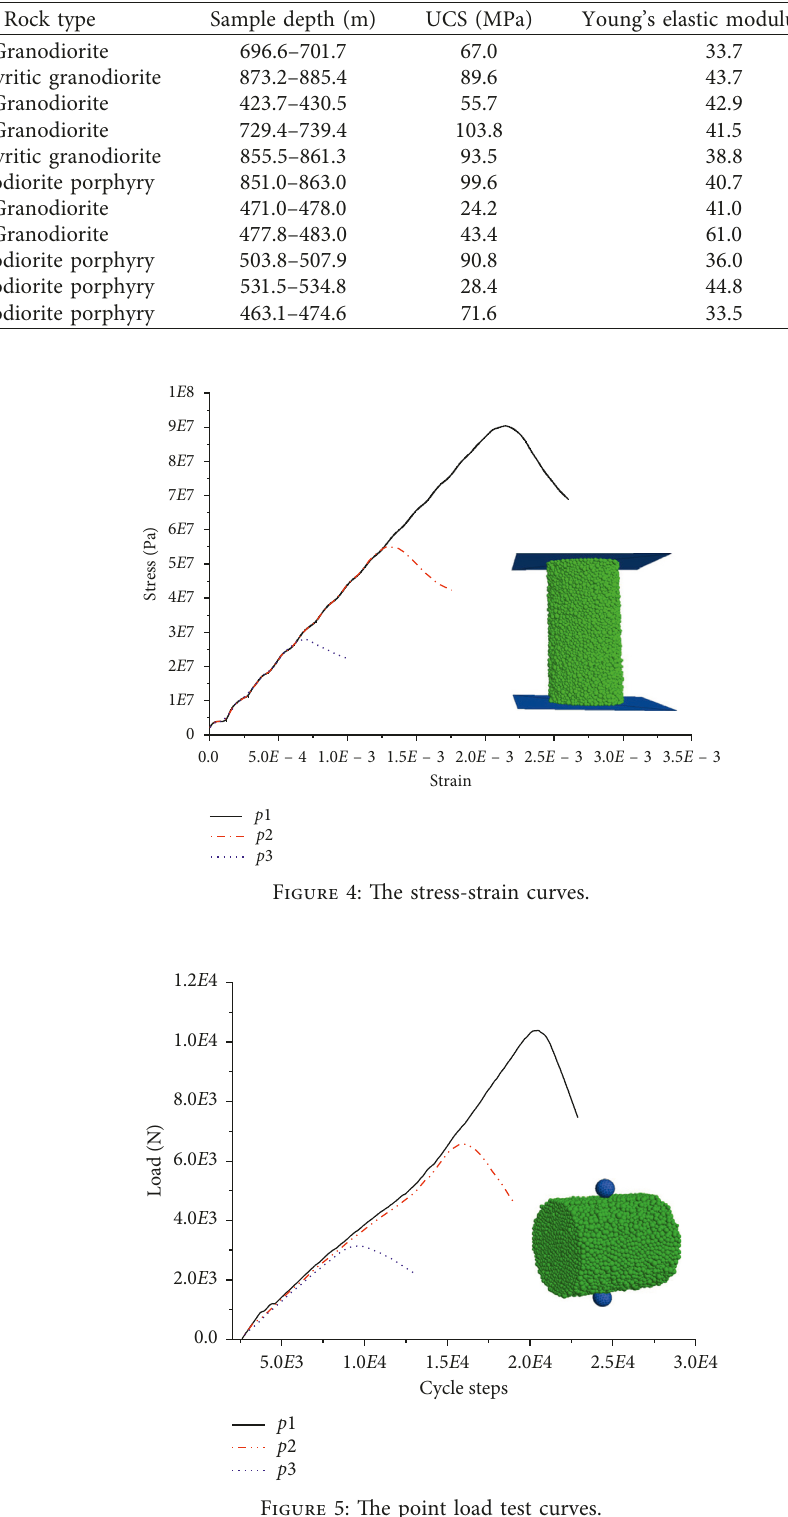
Figure 5: The point load test curves.